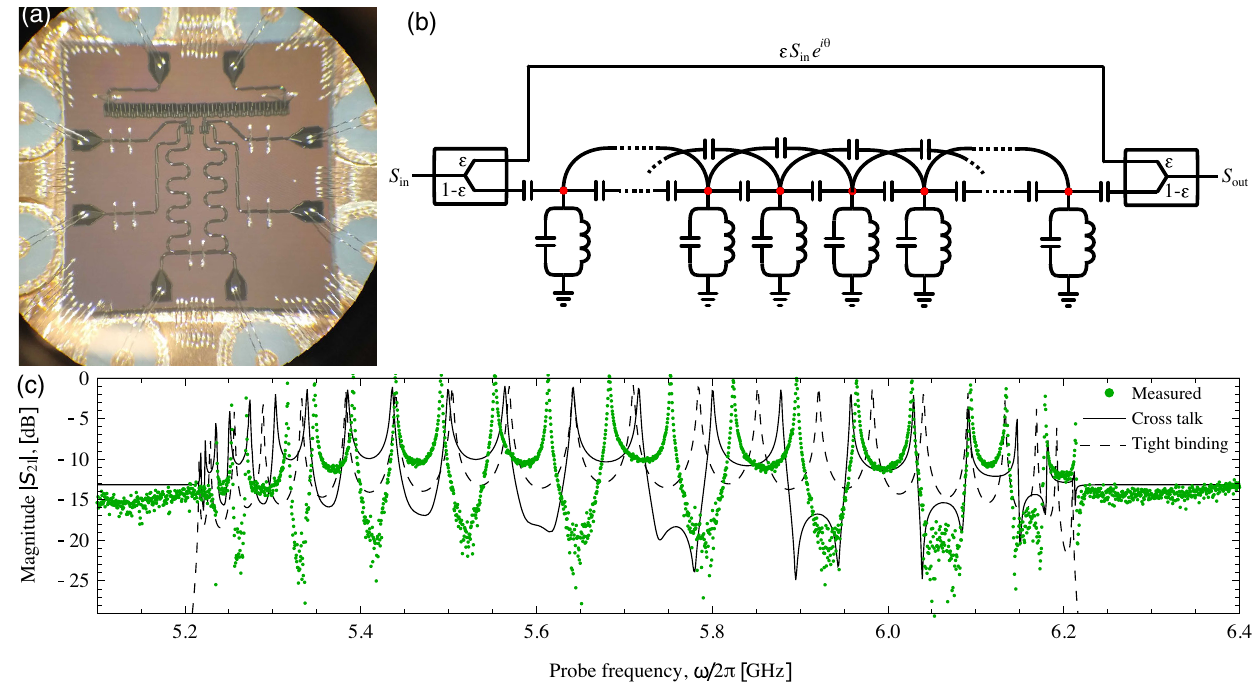
FIG. 16. Transmission cross-talk. (a) Micrograph of the sample bonded in the copper sample box. The 1.5-mm aluminium bond wires connecting the inner conductor of a coaxial cable to the bond pad on the chips have direct electromagnetic cross-talk. (b) Model of the cross-talk consisting in two power splitters/combiners: A small portion of the signal bypasses the waveguide and is recollected at the output, constructively or destructively interfering with the signal through the waveguide, and producing a nonzero transmission outside the band. (c) Measured transmission through the sample (green dots), which is not well reproduced considering only the ideal case (input-output theory at low power, red dashed line). The sum on the signal through the array and the cross-talk (black solid line) explain the nonzero transmission and the “ pairing ”